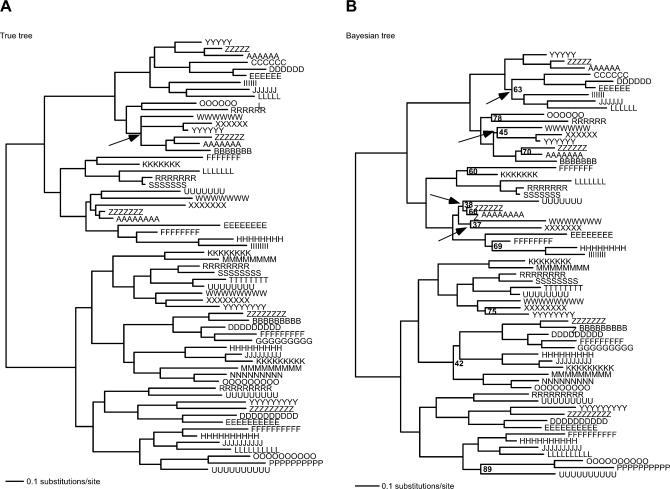
Typical Phylogenetic Trees(A) True 64-taxon tree initiated with nuoK sequences. The arrow indicates a near trichotomy.(B) Bayesian tree estimated from the same data as in (A). Numbers are posterior probabilities of clades whose posterior probabilities are <90%. Arrows indicate the clades that do not exist in the true tree.